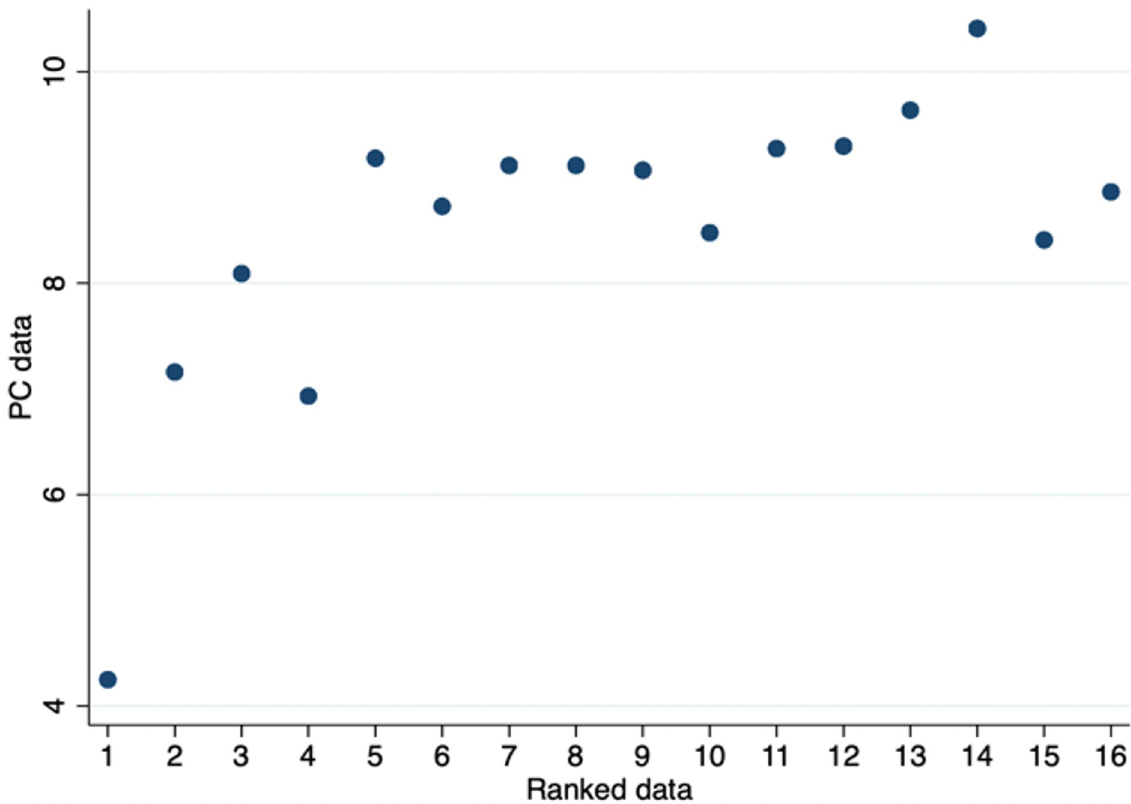
Fig 3. Policy-capturing vs. ranked data. The relationship between Policy-capturing data and Ranked data.